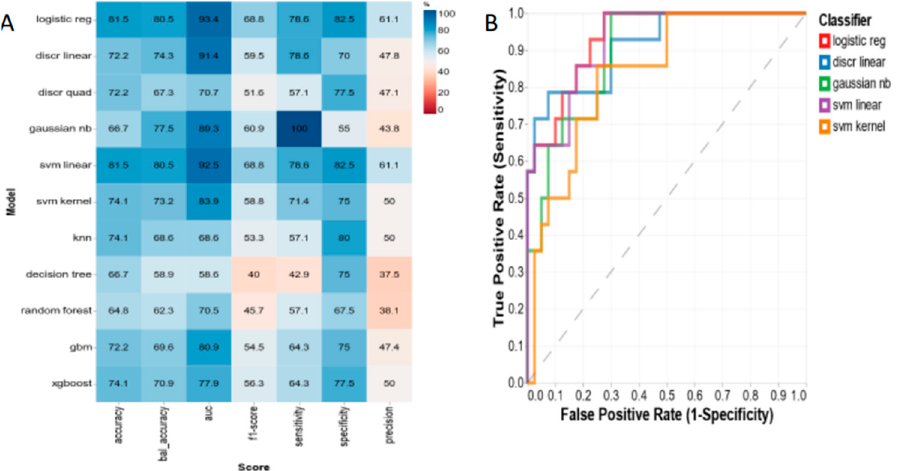
Figure 3. Fecal metabolite predictive models and receiver-operating characteristic (ROC) plots for three-month post-sleeve gastrectomy weight loss outcomes: highest %TWL tertile (T3) versus all patients at baseline. Note: %TWL = percent total weight loss; logistic reg = logistic regression; ridge clf = ridge classi fi er; discr linear = linear discrimination; discr quad = discrete quad; gaussian nb = Gaussian Naive Bayes; svm linear = support vector machine linear; svm kernel = support vector machine kernel; knn = K-nearest neighbors; gbm = generalized boosted regression modeling; xgboost = extreme gradient boosting.